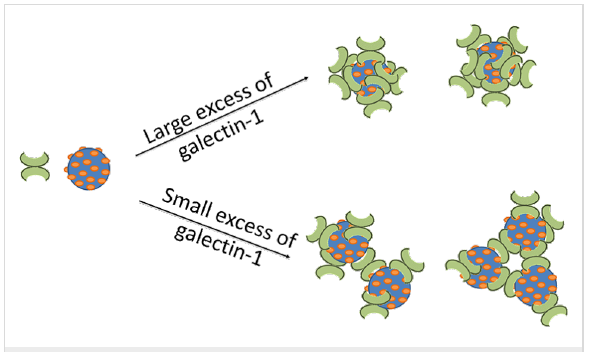
Figure 8: Schematic representation of galectin-1/glycodendrimer aggregates at varying stoichiometries.